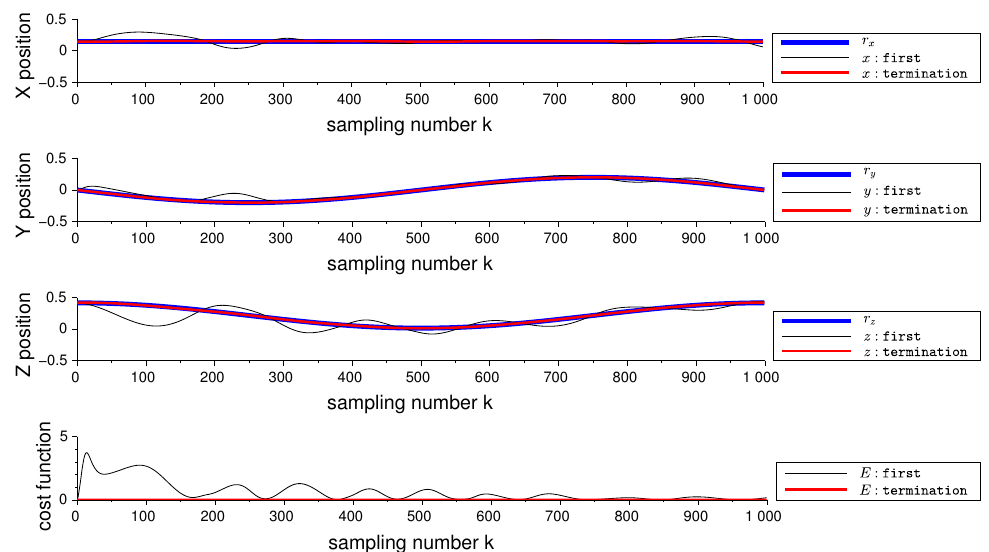
Figure 4. An example of system responses in the workspace for controlling the robot manipulator using the QNN-based feedforward–feedback controller and the variation of the cost function. In the top three figures, the desired trajectory’s reference signal is drawn with a thick line, and the system response within the first iteration and the response that terminates the network training are drawn with thin and medium thick lines, respectively. In the bottom figure, the cost function within the first iteration and that which terminates the network training are drawn with thin and medium thick lines,